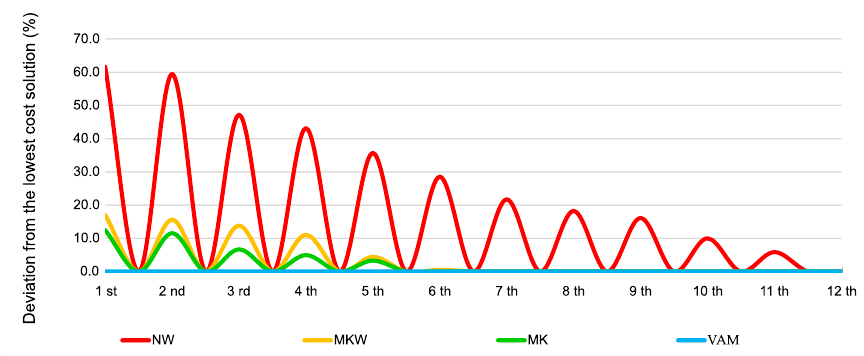
Figure 6. Deviation from optimal